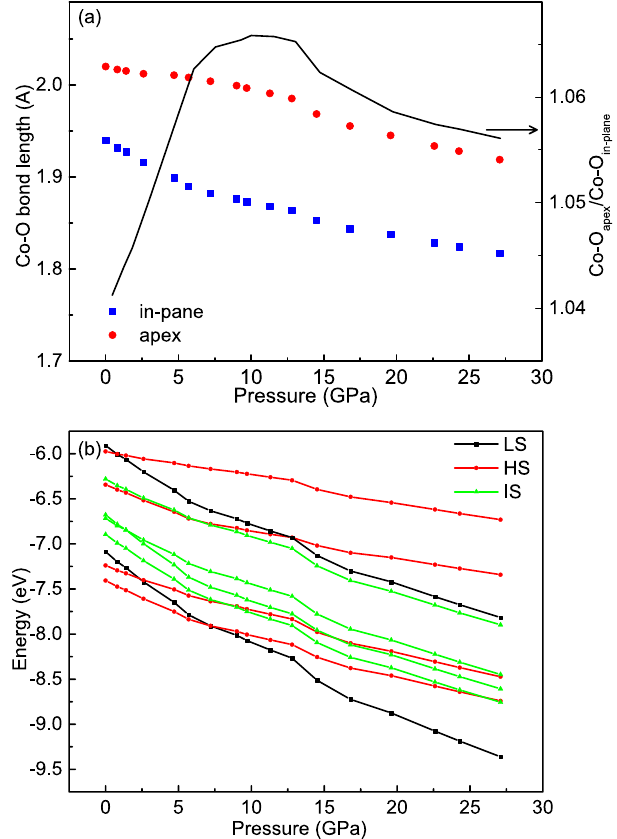
Figure 6. ( a ) Co-O apex bond length (red circles) and Co-O in-plane bond length (blue squares) as well as the ratio Co-O apex /Co-O in-plane (black line) as a function of the external pressure derived from ref. 28. Note that the reduction of the in-plane Co-O bond distance might be overestimated due to the possible rotation of the CoO 6 octahedron. ( b ) The energy diagram of three spin states as a function of the pressure using Co-O bond lengths in ( a